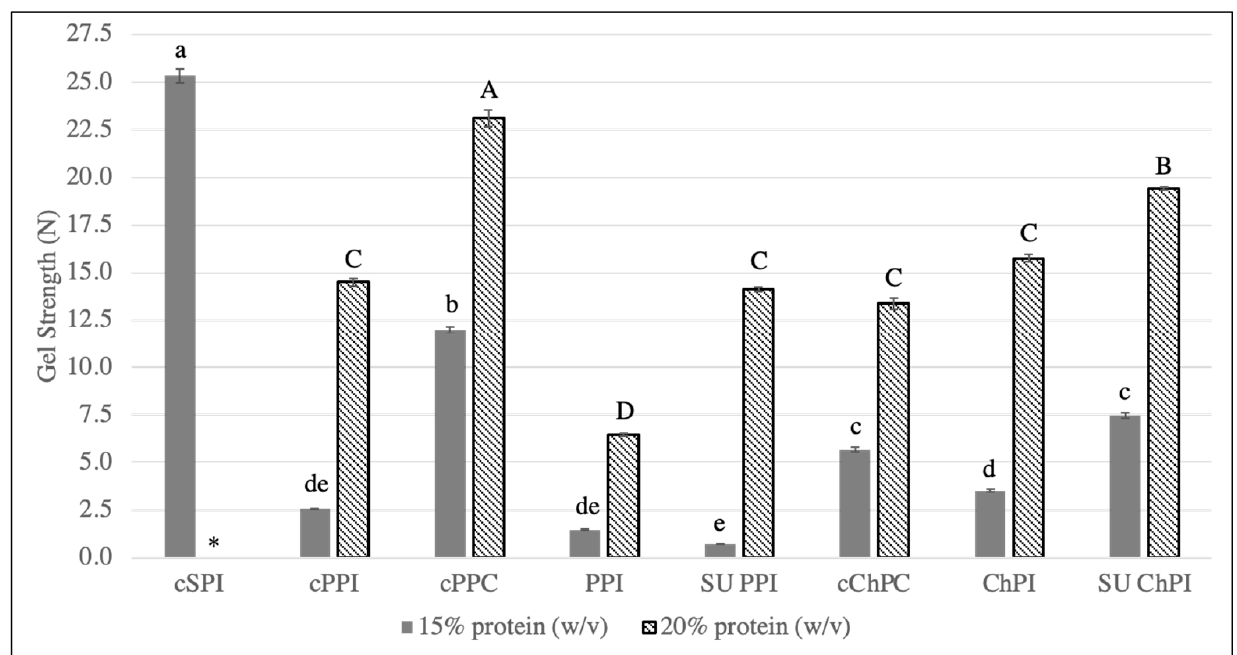
Figure 3. Protein gel strength of benchtop and scaled-up pea and chickpea protein isolates (PPI,